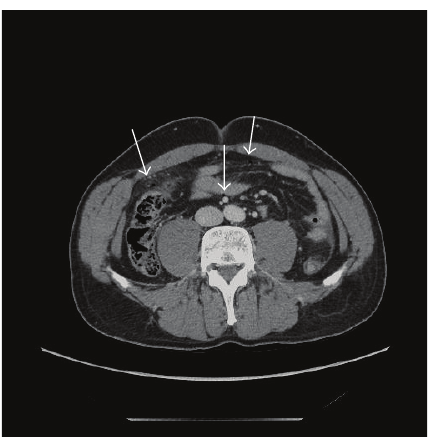
Figure 3: Contrast enhanced axial CT of the abdomen in a 45-year- old male with an inguinal trauma, showing free intraperitoneal air